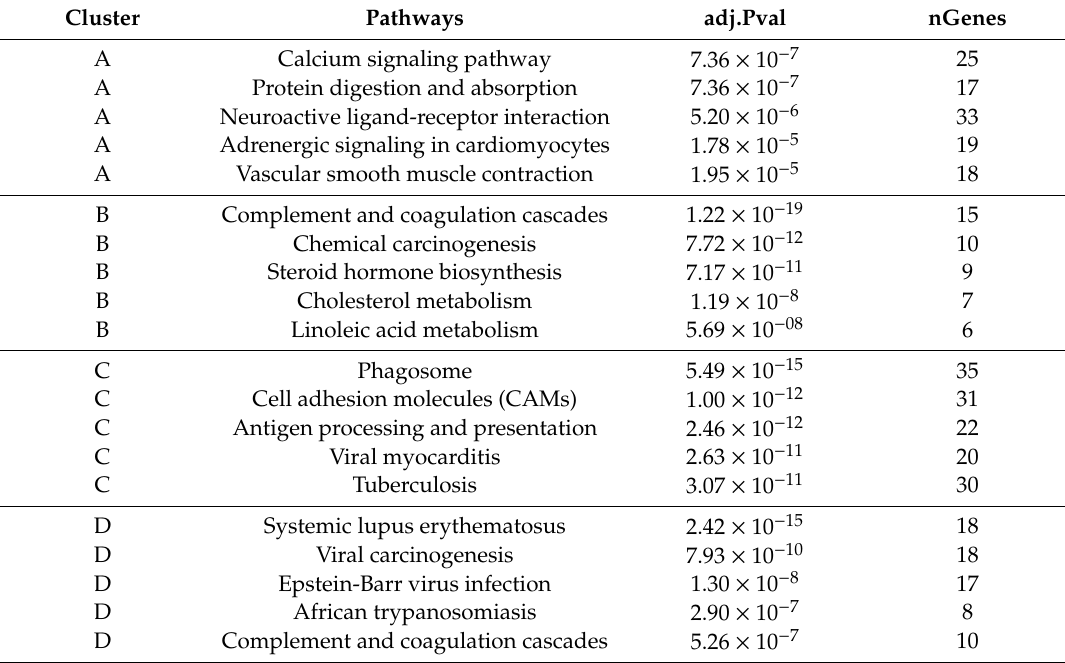
Table 2. Top five pathways from each cluster, p-values, and the total number of genes involved in each